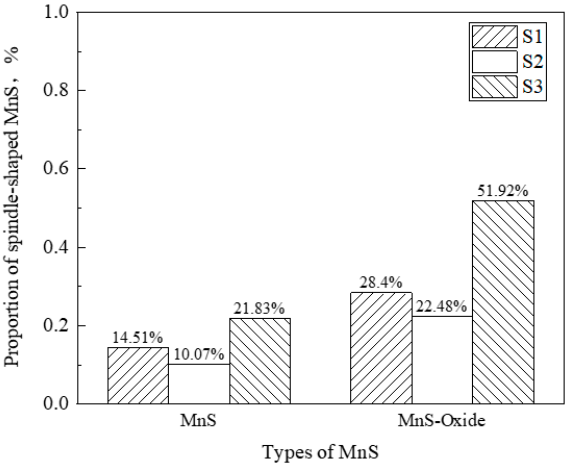
Figure 5. Percentage of spindle-shaped MnS in different types of sulfides.